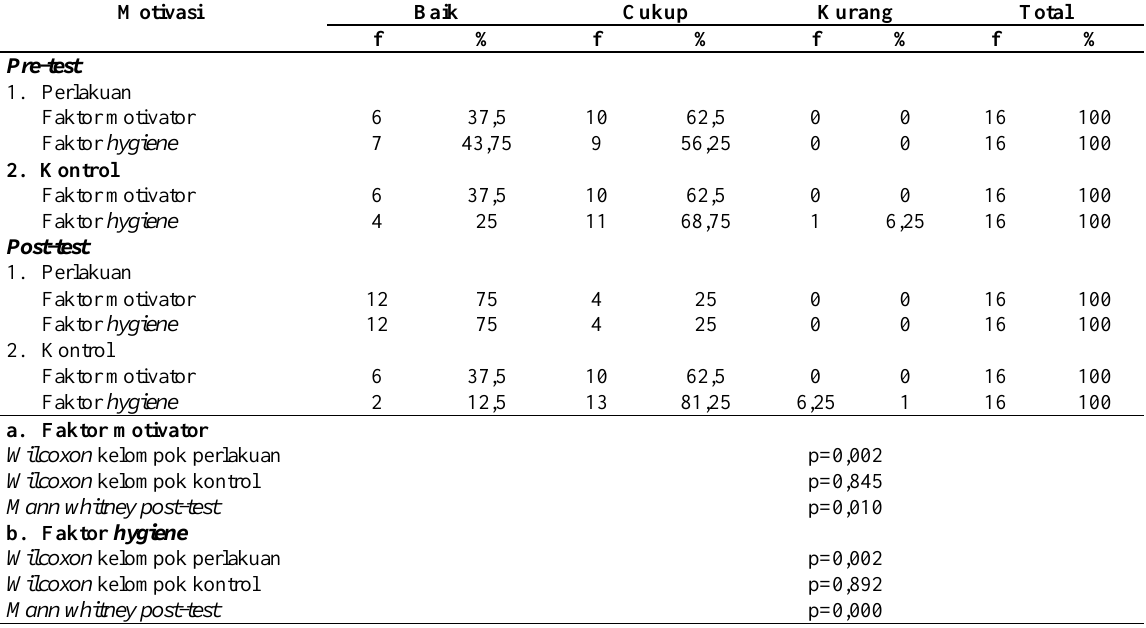
Tabel 7. Distribusi frekuensi motivasi perawat pelaksana pada kelompok perlakuan dan kontrol Motivasi